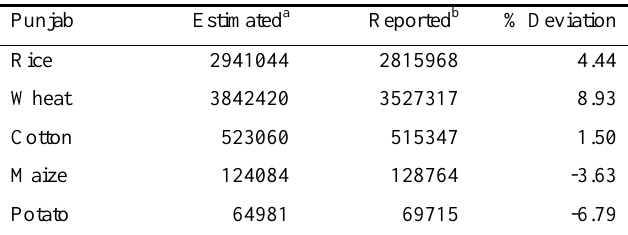
Table 3. Comparison of major cropped area (in ha) between estimated, based on MODIS EVI (2011-12), and DES reported statistics. a Estimated from MODIS EVI time series image (2011-12), b DES reported